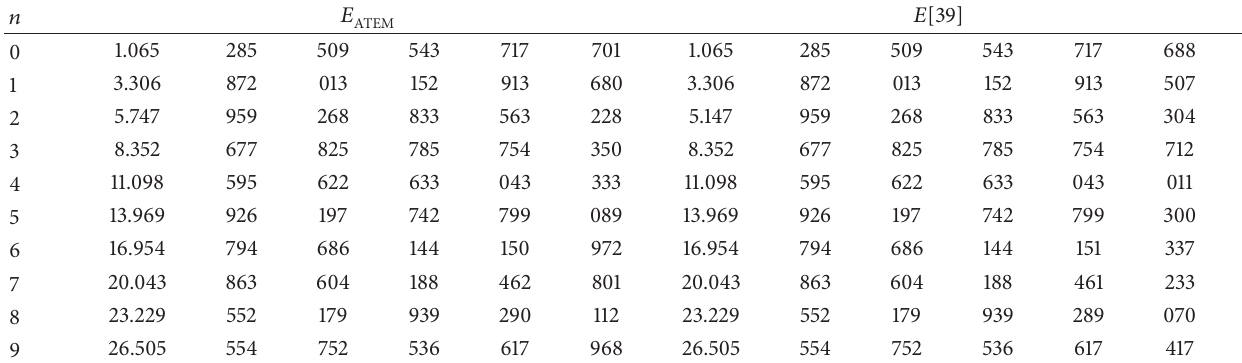
Table 2: The first ten eigenvalues of the potential in (15) for 𝑔 = 0.1 . Number of iteration is set to 𝑚 = 120